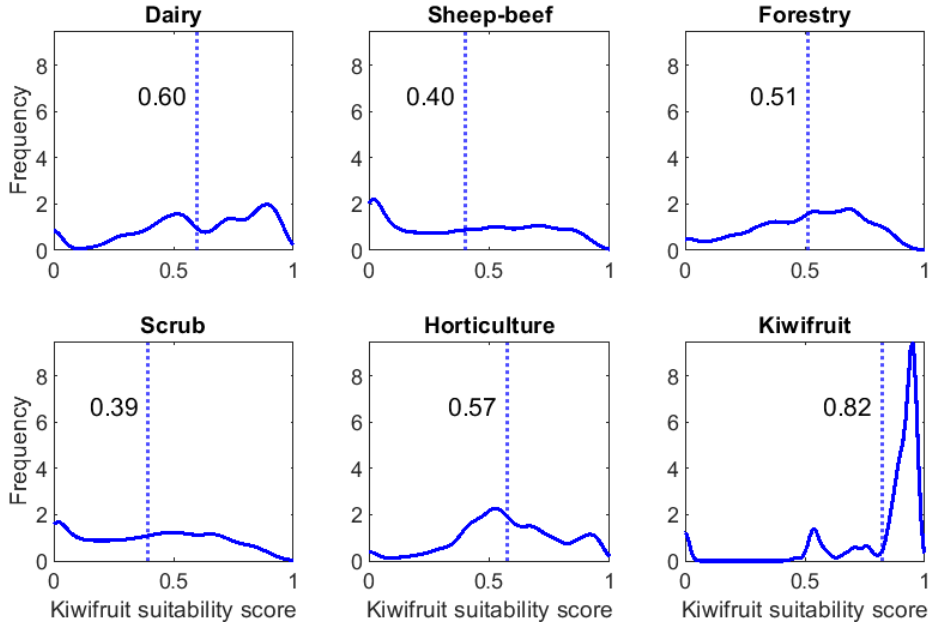
Figure 11. The frequency distribution (solid line) and mean (dotted line with value indicated) of kiwifruit suitability scores (using 1972–2005 climate model data) for different observed land uses. Horticulture indicates all horticultural industries other than kiwifruit and apple.